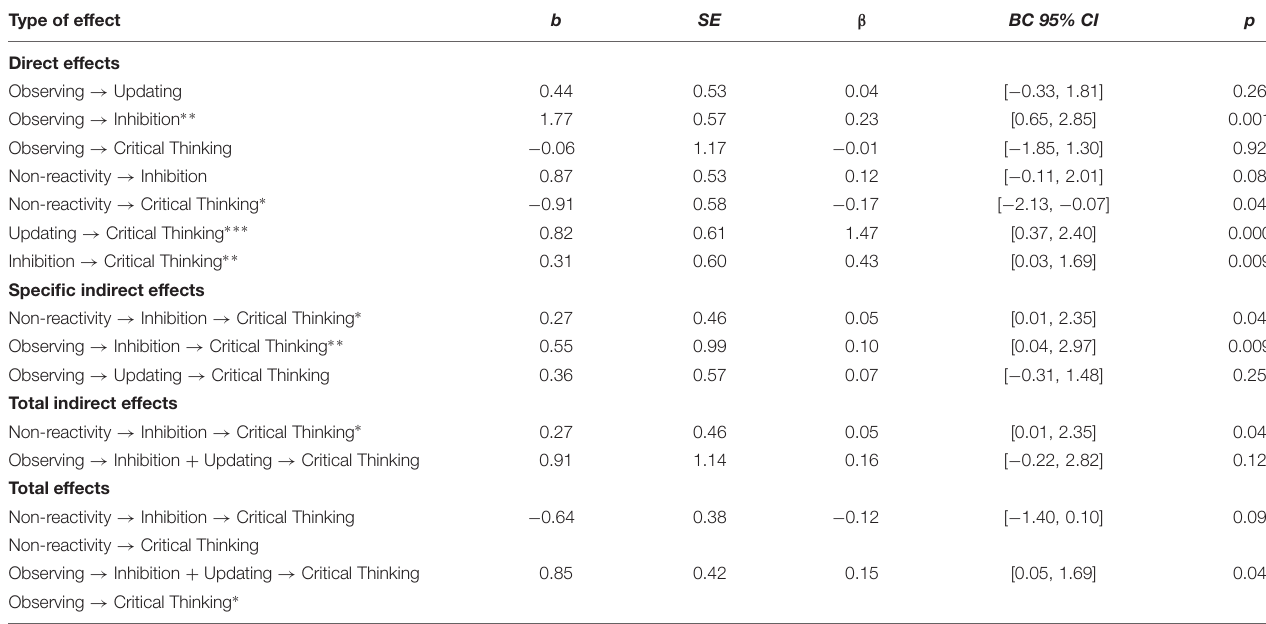
TABLE 4 | Estimates in the multiple mediation